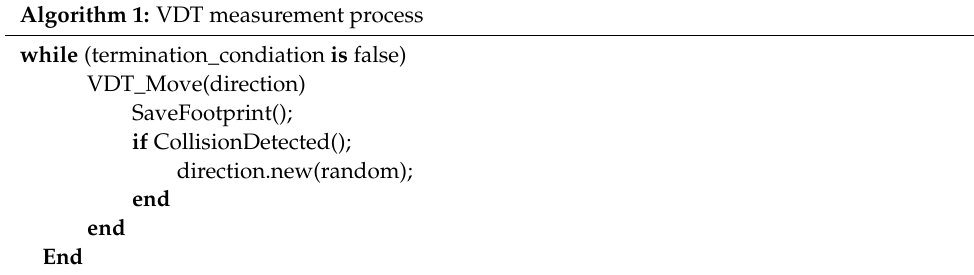
Algorithm 1: VDT measurement